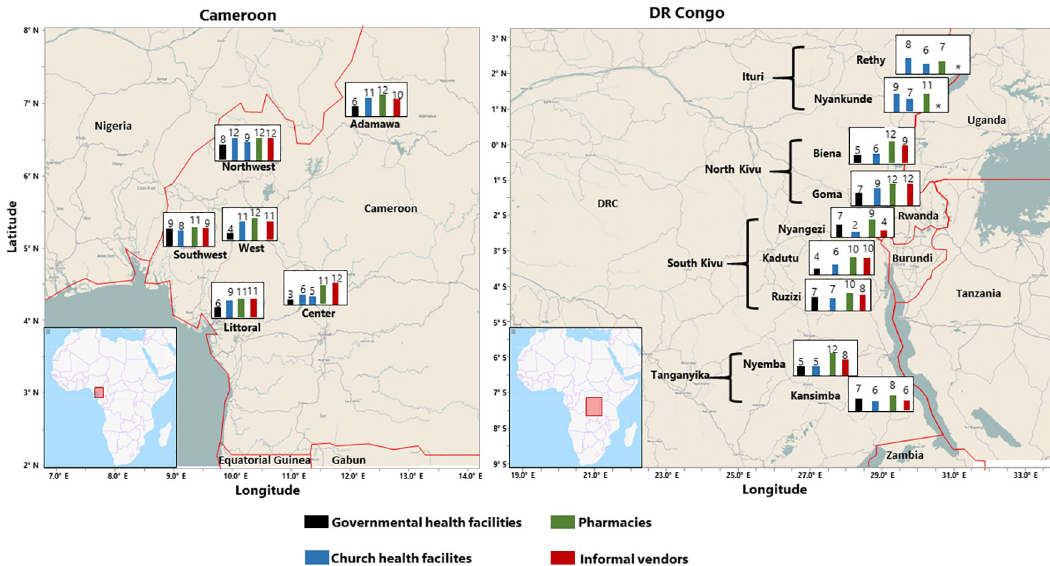
Fig 1. Map of the sampling regions, with numbers of medicines available at different types of facilities. 12 medicines were included into this study in each country. Therefore the maximum number of medicines recorded as available is 12. In the Ituri province in the DR Congo the health facilities under governmental authority were actually run by church organisations, therefore they were classified as church health facilities. � no informal vendor was identified in these health zones.